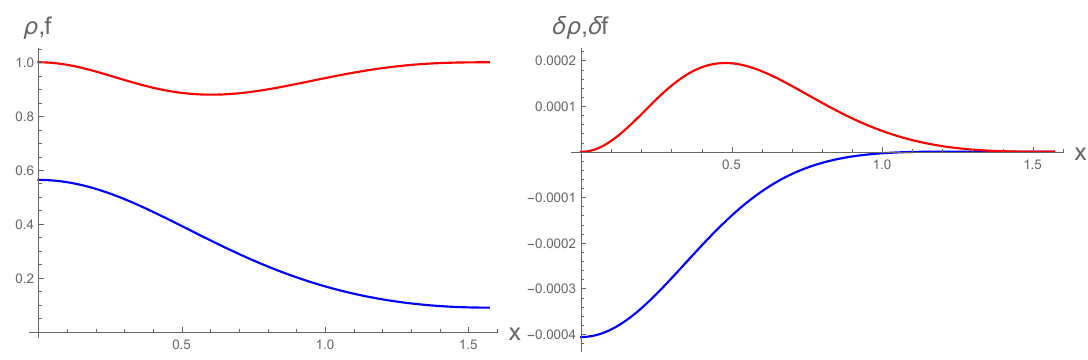
Figure 16 . Left: (cid:26) ( t 0 ; x ) (blue) and f ( t 0 ; x ) (red), as obtained from a numerical simulation with ! = 2, (cid:15) = 0 : 09, (cid:12) = 21 : 222683 at t 0 = 26 : 075. Right: di(cid:11)erence of the functions on the left plot with respect to their values on the unstable SPS, ( (cid:14)(cid:26) )( t 0 ; x ) (blue) and ( (cid:14)f )( t 0 ; x ) (red).